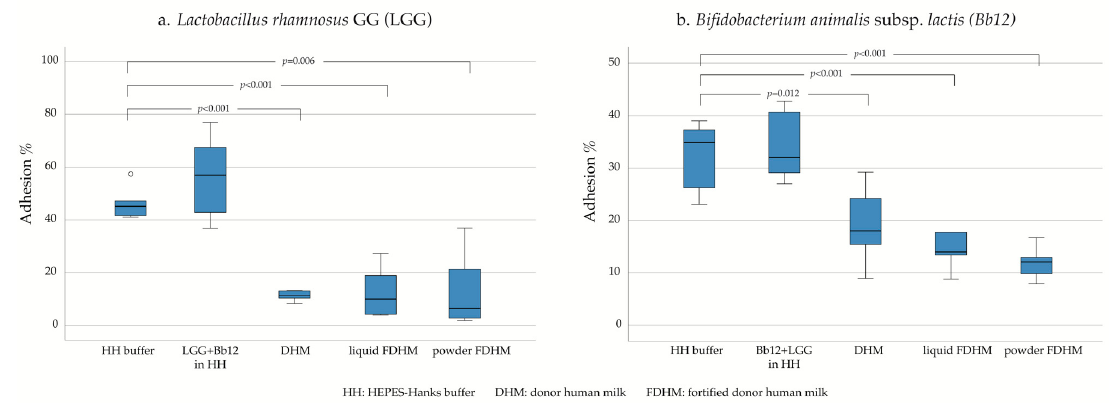
Figure 1. The adherence of L. rhamnosus GG ( a ) and B. lactis Bb12 ( b ) to human intestinal mucus glycoproteins in vitro as presented with box plot with outliers marked with a circle (o). Subject age was an important factor when determining the adhesion of probiotics alone to mucus, depending on the strain used. Mucus isolated from >6-month-old infants (49.2%) appeared to facilitate more adhesion of LGG compared with the mucus isolated from <6-month-old infants, albeit the difference was not statistically significant (43.3%, p = 0.26; Figure 2). In contrast, Bb12 showed significantly higher adherence to mucus isolated from <6-month-old infants (27.8%) when compared with mucus from >6-month-old infants (37.3%; p = 0.05).